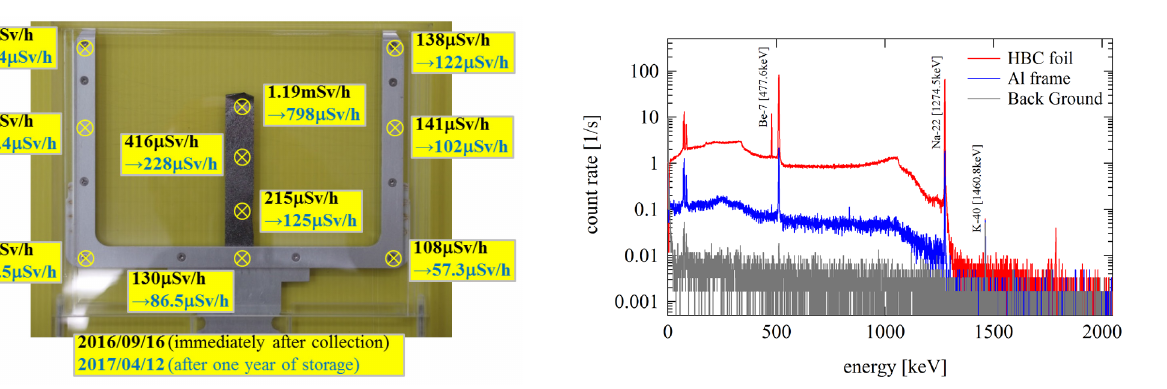
Fig. 7. Transition of residual dose rate measured on collected foil and frame.